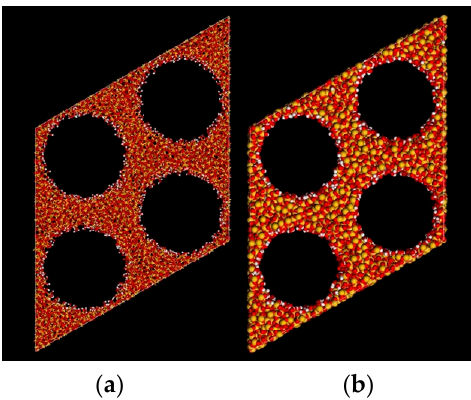
Figure 8. The final structure of the MCM-41 model. ( a ) Ball-and-stick model; ( b ) CPK model; silicon (Si), yellow; oxygen (O), red; hydrogen (H), white.